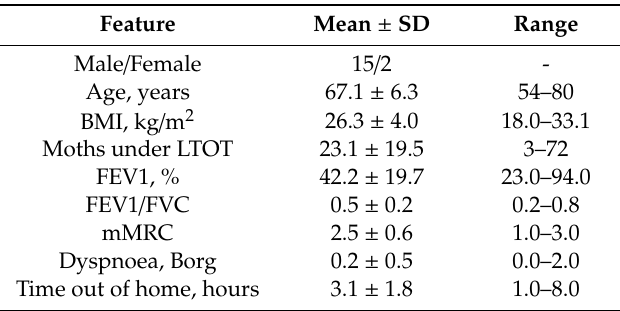
Table 1. Clinical and functional characteristics in the study group.